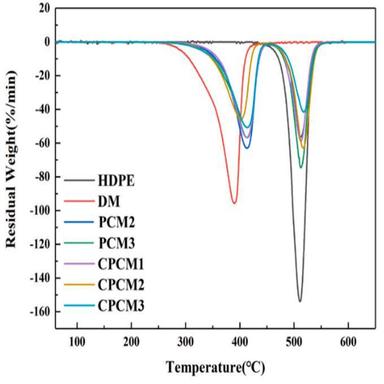
DTG curves of the HDPE, HD, PCM2–PCM3, and CPCM1–CPCM3.